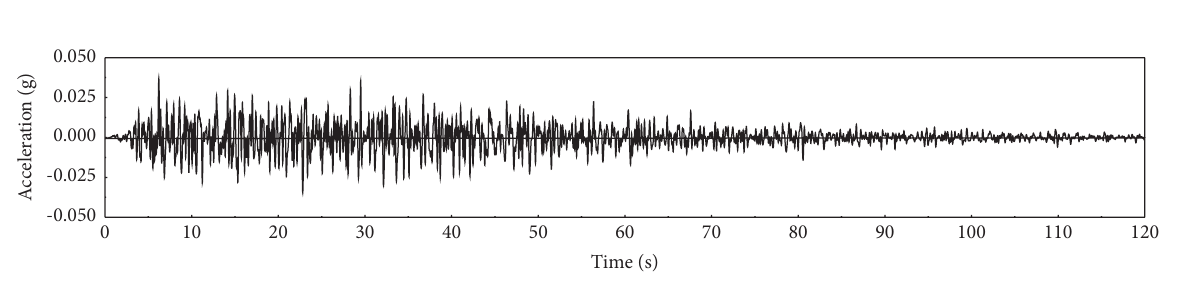
Figure 9: BCJ-L2